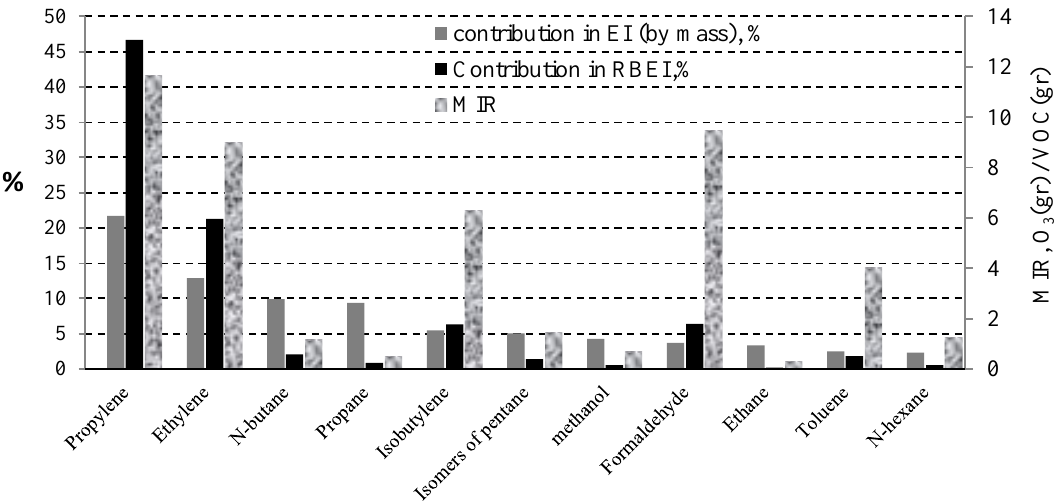
Figure 3 . Comparison of the contribution of VOCs in Emission Inventory (by mass%, right axis, red column), Reactivity-Based Emission Inventory (%, right axis, blue column) and MIR (gr O left axis, yellow column)